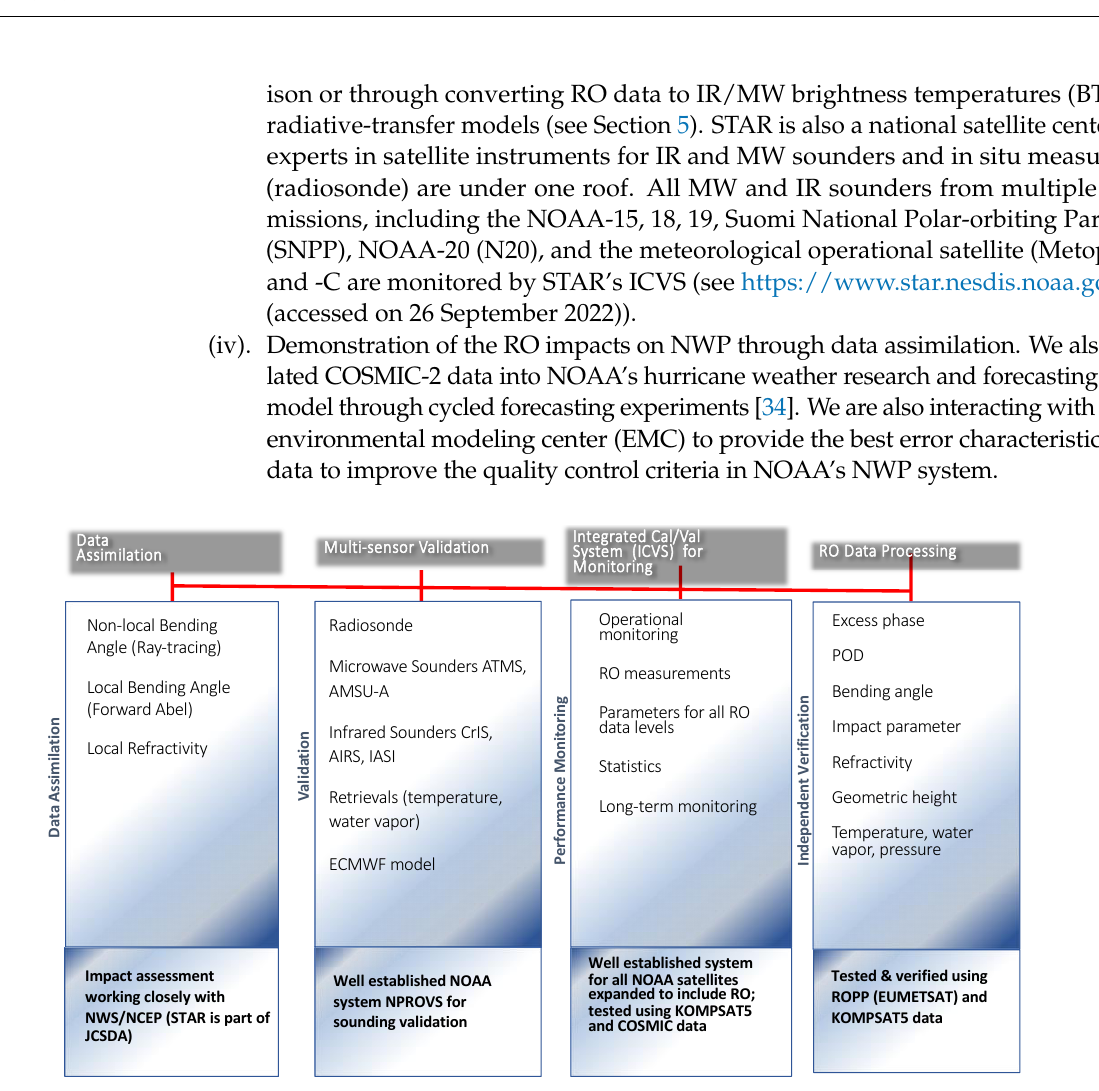
Figure 1. The focus functions of the STAR GNSS RO Data Processing and Validation System.